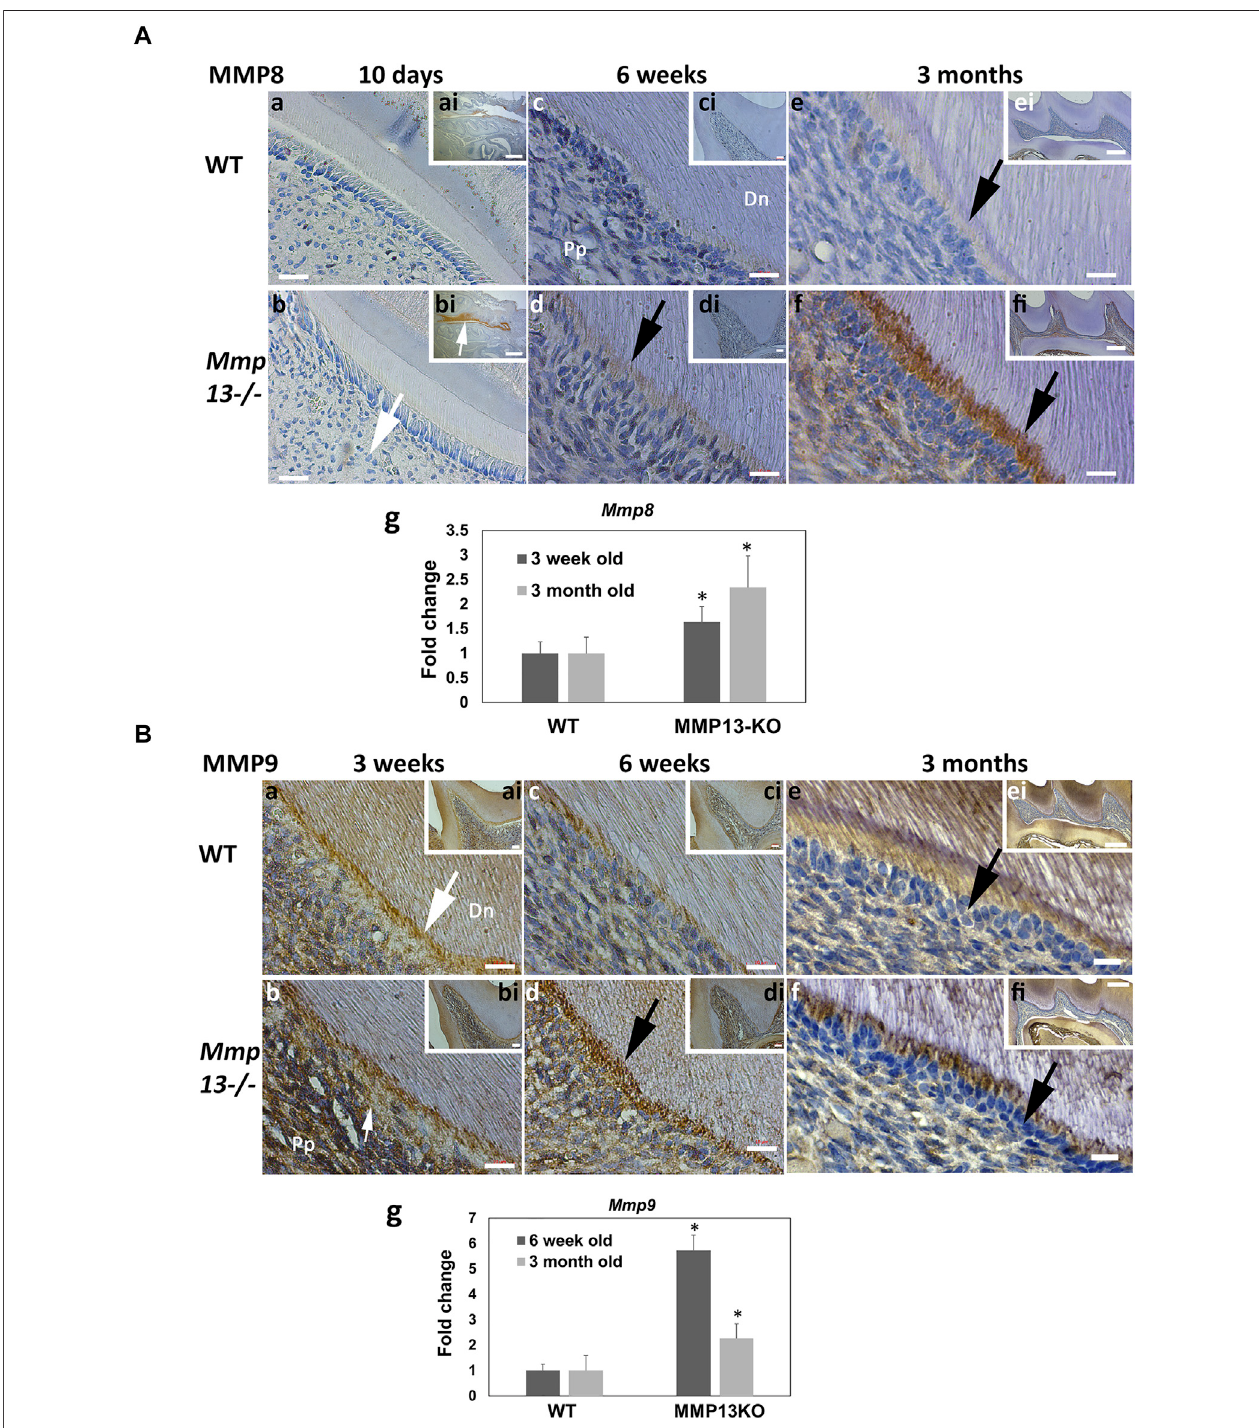
FIGURE 5 | Dentin – pulp expression of other MMPs, MMP-8 and MMP-9, is altered after MMP13-ablation. (A) Dental expression of another collagenase, MMP8, wasincreasedin Mmp13 − / − and mature teeth (a – f) . MMP8expression waslowindevelopingmolars( a,b — large whitearrow)but highinthe oralmucosaofMMP13KO ( bi [inset] white arrow). MMP8 expression progressed in pulp tissue, odontoblast layer, and predentin ( d, f — black arrows) compared with WT (c, e) over time. c – f representhigher magni fi cations ofthemesialcuspareaofthedistal cuspofimagesinset ci – fi .Scalebars= (a,b) 5 μ m(originalmag.×63); (ai,bi) 200 μ m(original mag. ×2.5); (c – f) 10 μ m (original mag. ×63); (ci, di) 20 μ m (original mag. ×20); and (ei, fi ) 10 μ m (original mag. ×10). qRT-PCR shows increased Mmp8 expression in pulptissuefromMMP13KOincisorsatboth3-weekand3-month (g) ,whileDPCcultureoftissuefromWTand Mmp13 − / − mousemolarshighlightsasigni fi cantincrease